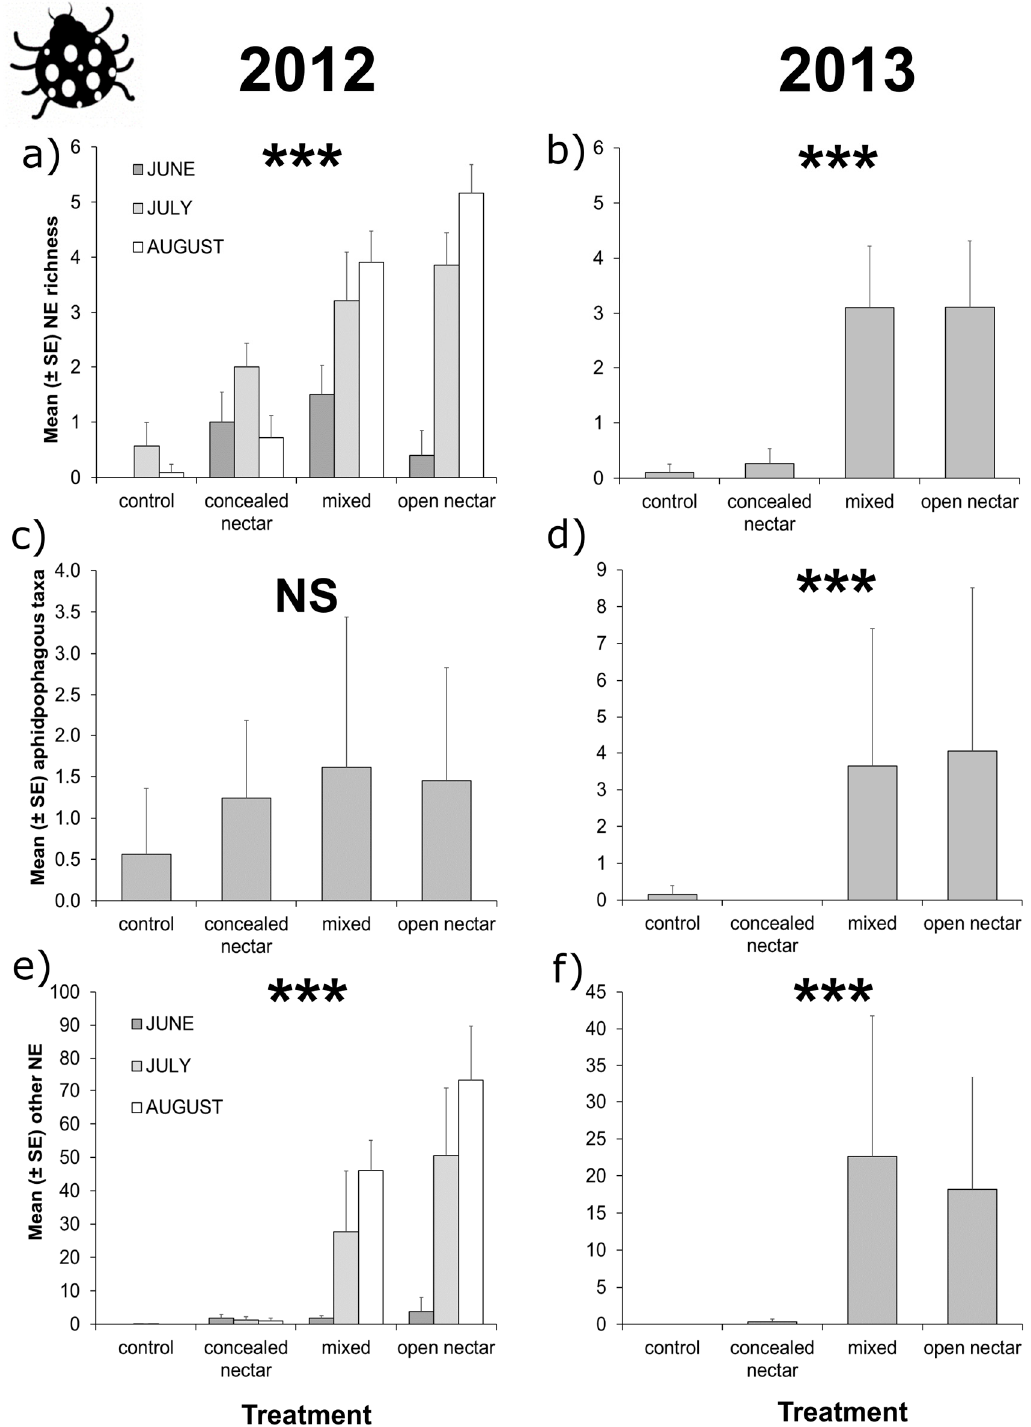
Figure 2. Effects of flower strips on flower-visiting natural enemies in orchard alleyways. We detected a significant effect of treatment on aphidophagous taxa in 2013 but not in 2012 ( c , d ); Other natural enemies and overall natural enemy richness were affected by the interaction between treatment (control, concealed-nectar, mixed, and open-nectar) and sampling month (June, July, and August) in 2012 ( a , e ); but by treatment only in 2013 ( b , f ). Error bars show standard errors and asterisks show level of significance (NS = p > 0.05, * = p < 0.05, ** = p < 0.01, *** = p < 0.001) reported in LRTs (see Table 1 and main text for details).